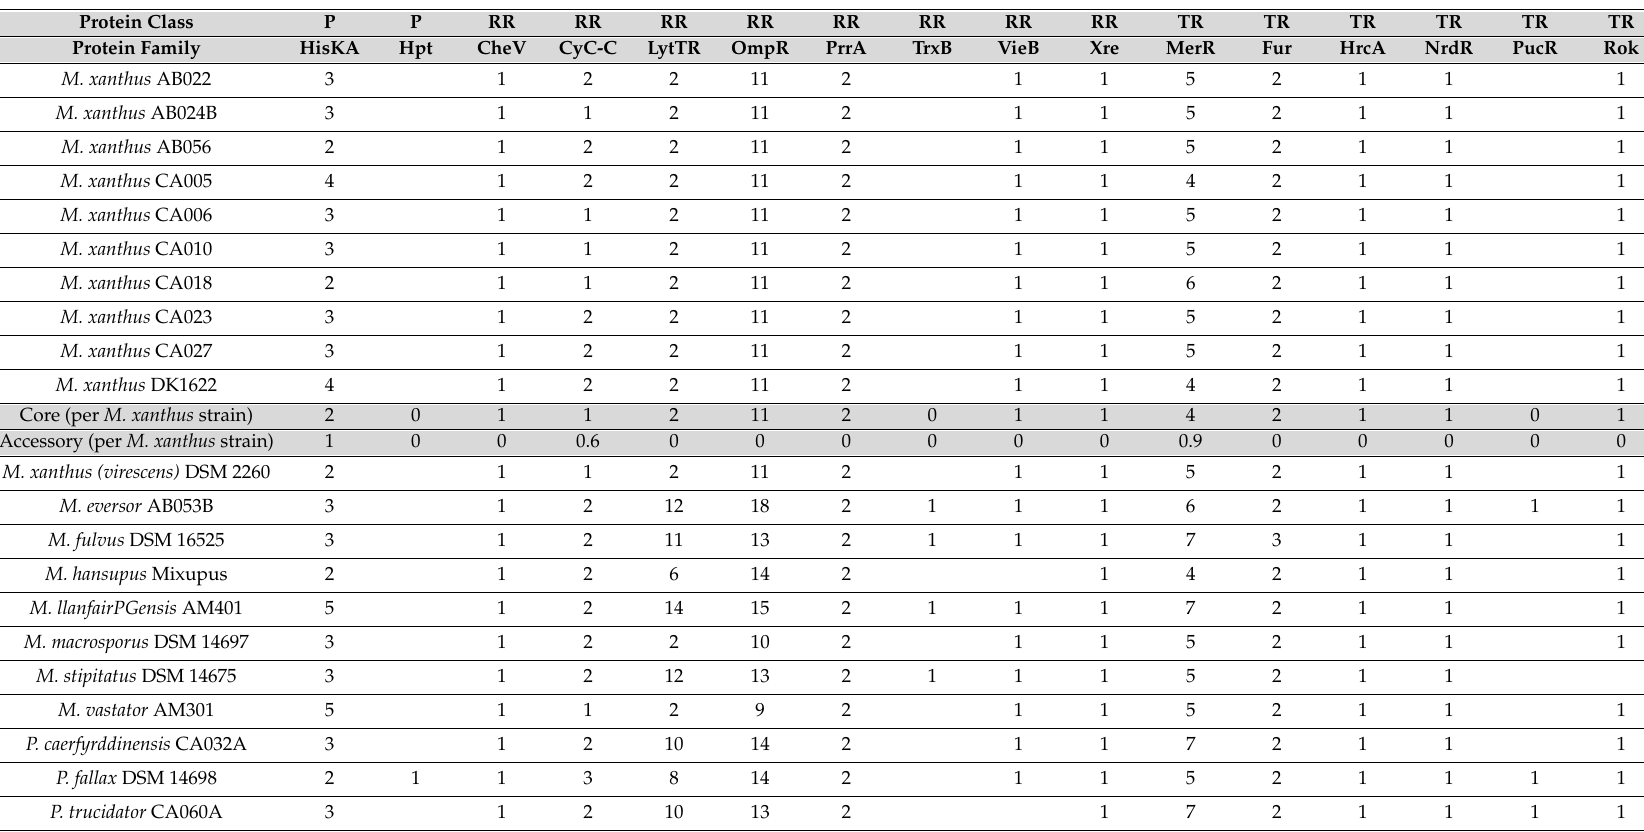
Table 3. Numbers of illustrative protein family members per genome. Genomes are presented in four taxonomic groupings with the same background shade. Also shown are the inferred numbers of proteins in the core and accessory genomes of M. xanthus strains. Protein